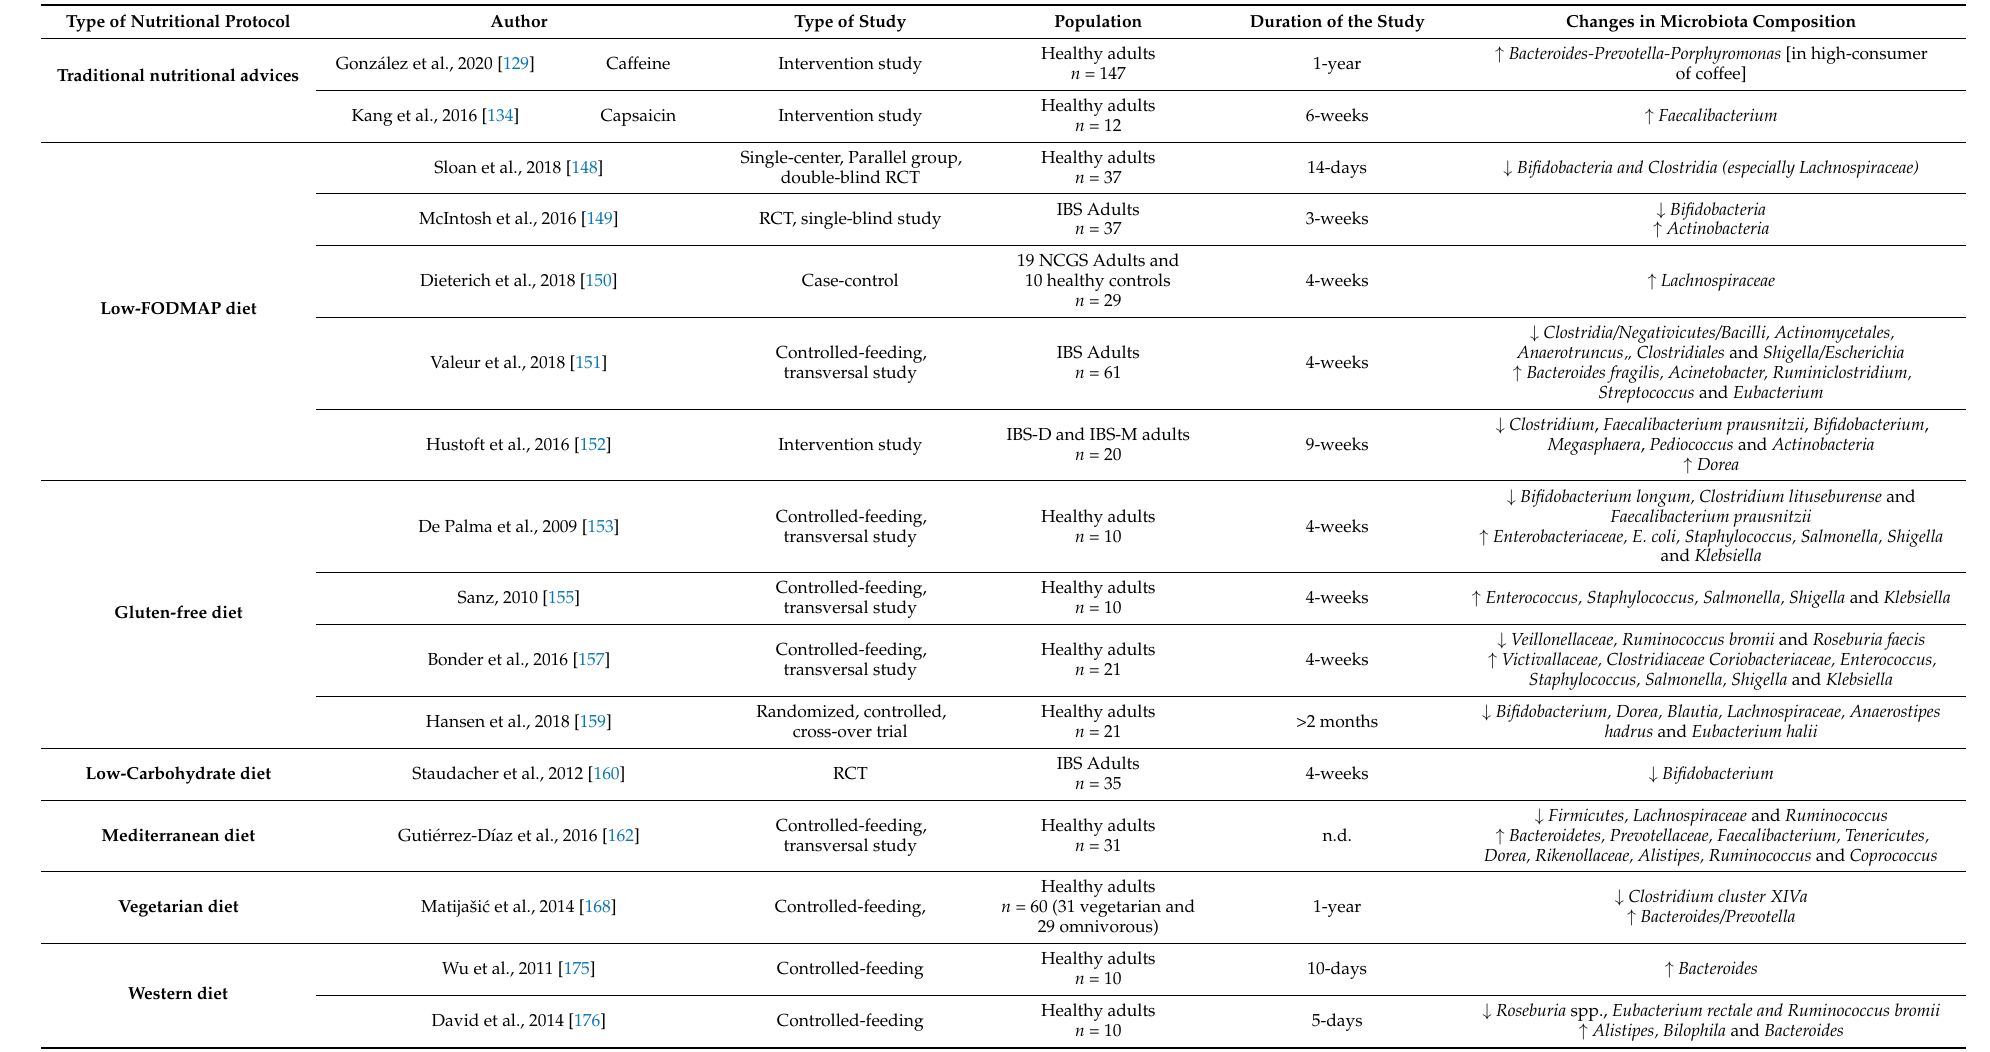
Table 2. Effects of different nutritional protocols on the intestinal microbiota in healthy subjects or IBS